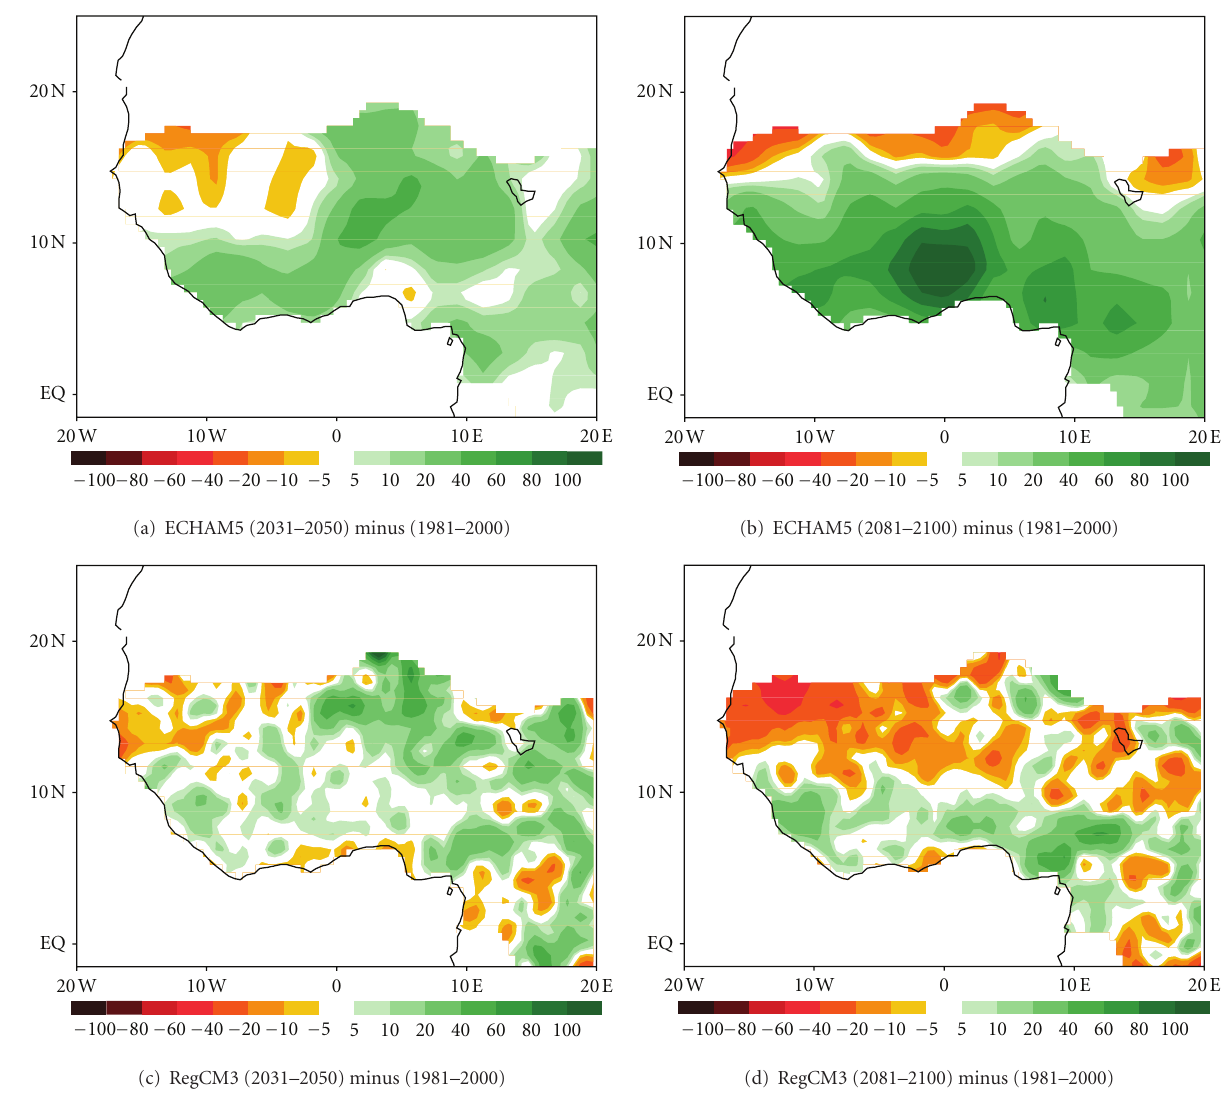
Figure 9: The same as Figure 8 but for the highest one-day